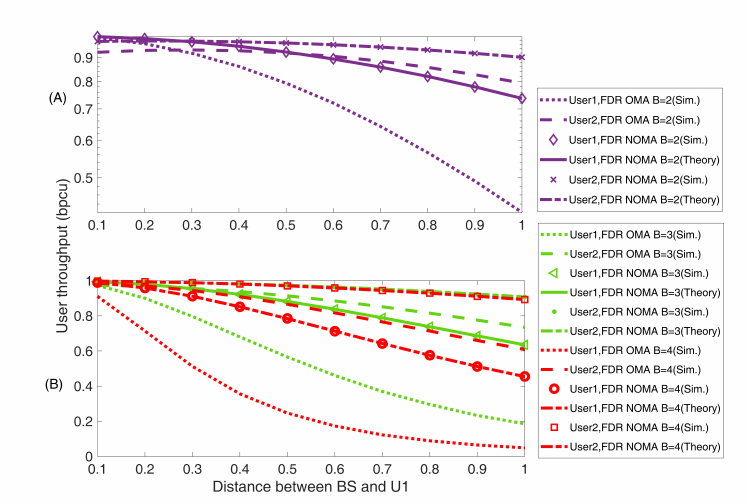
Figure 9. User throughput versus distance of U1, i.e., UAV from BS for UAV-FDR based-NOMA and OMA schemes in delay-limited transmission mode ( E ( | h LI | 2 ) = − 15 dB